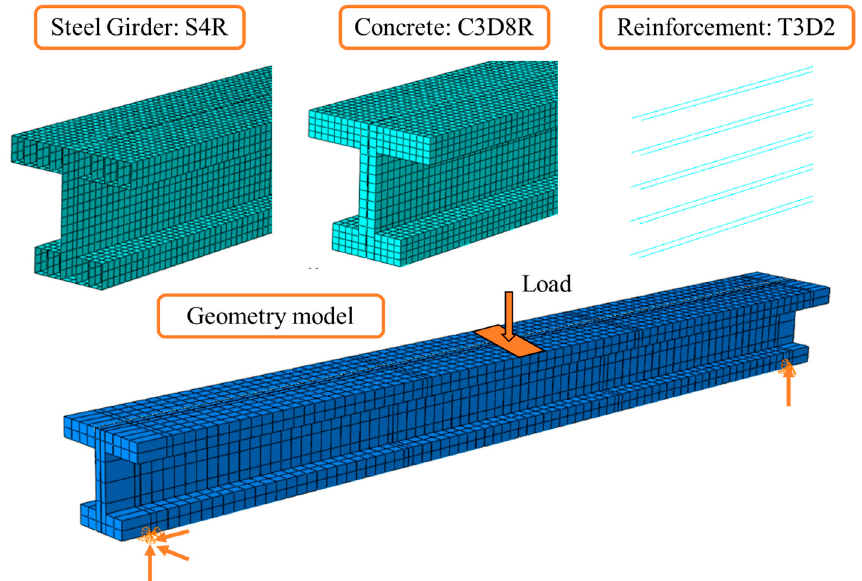
Figure 14. Discretization, element types and loading and boundary conditions in the FEM model.